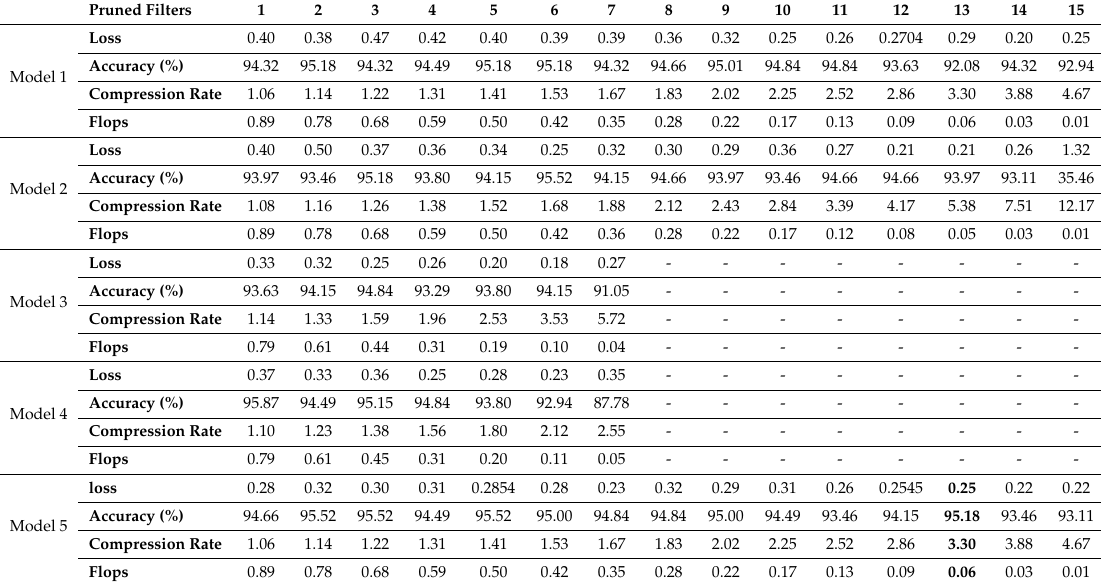
Table 7. Results for filter pruning with iterative